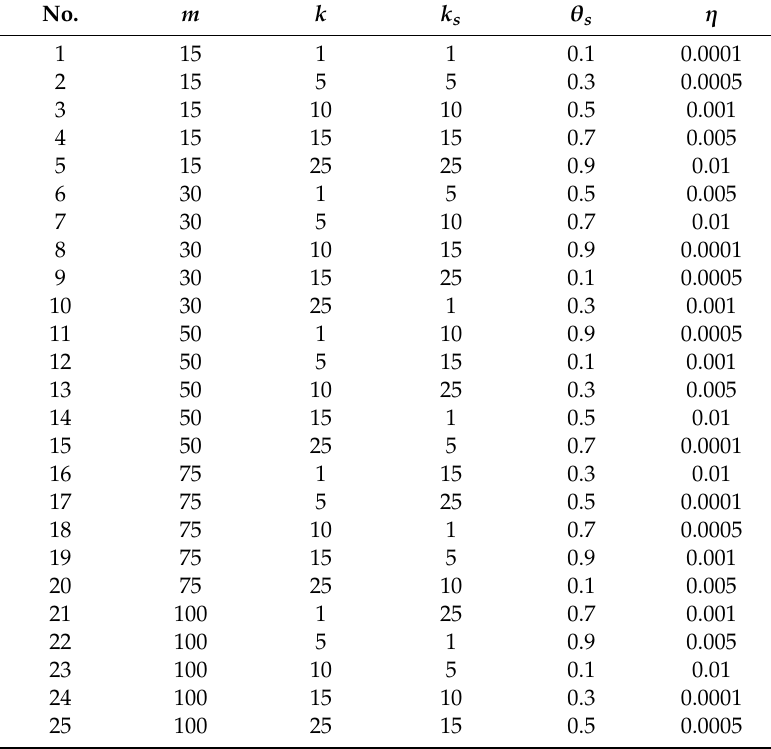
Table 9. Parameter combination of F2 and F3.